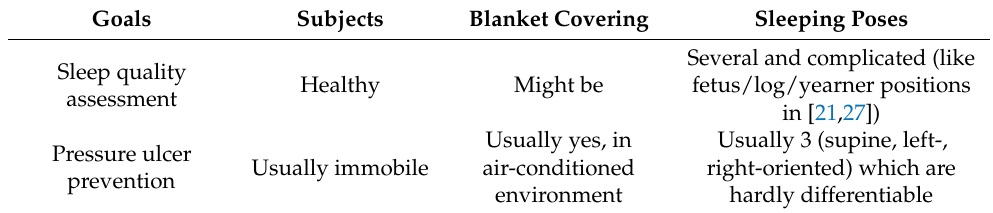
Table 1. A comparison between sleep quality assessment and our pressure ulcer prevention.